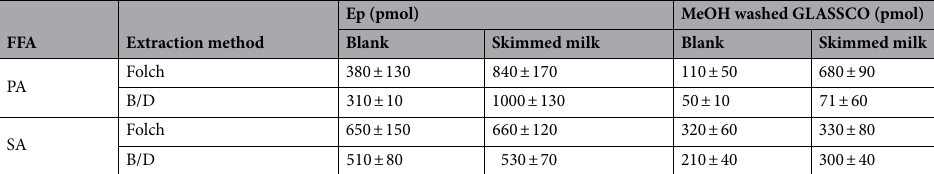
Table 2. Quantification of PA and SA in skimmed milk. Blank indicates the amount of FFA contaminants extracted from an empty tube without the introduction of skimmed milk. Data are presented as the mean ± SD ( n =